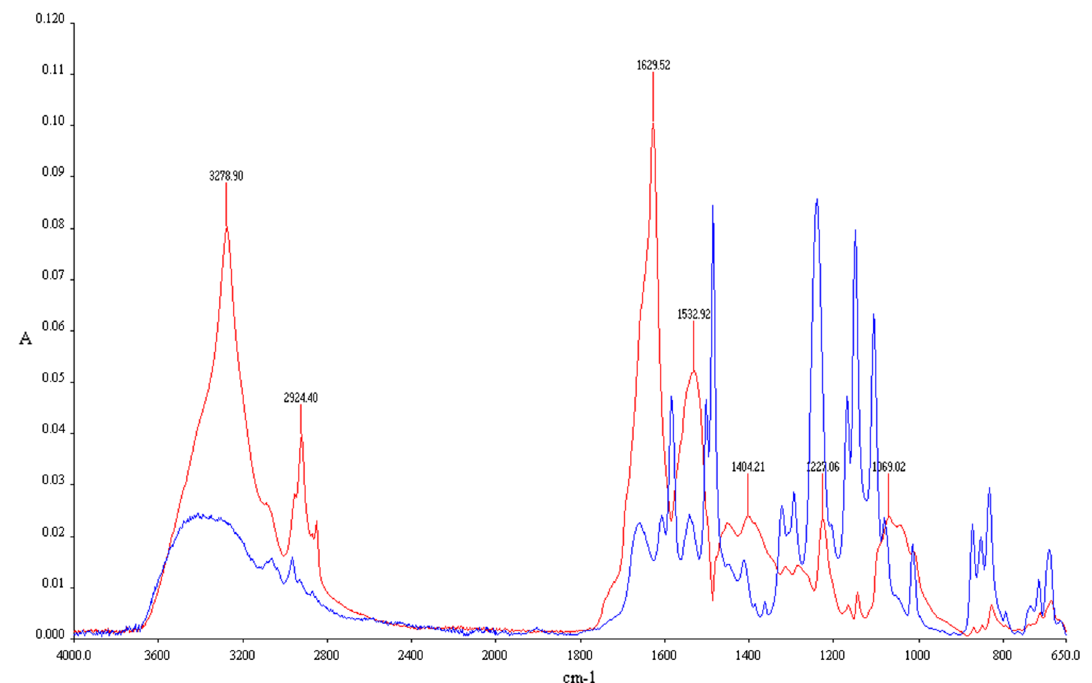
Fig. 7 FTIR spectra of the virgin (blue) and fouled (red) Hydranautics membrane